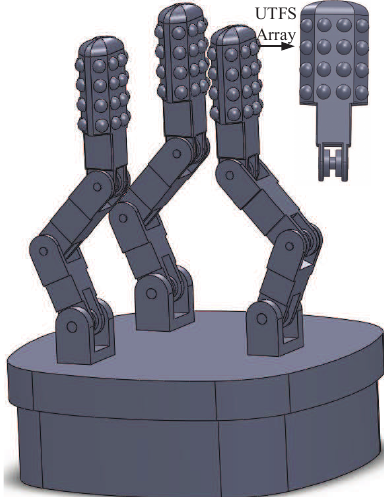
Figure 2. The structure of underwater dexterous hand with UTFS